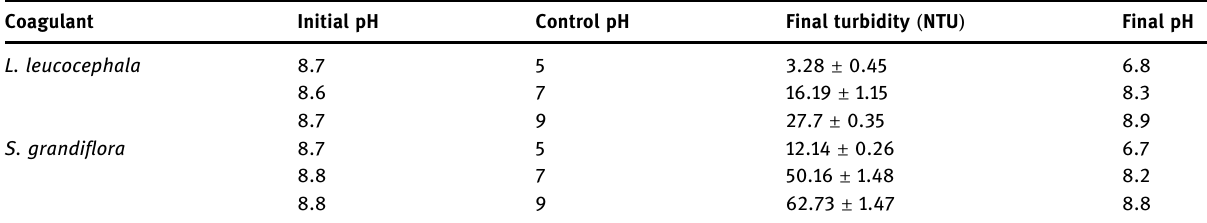
Table 2: E ff ect of pH on the removal of turbidity from turbid water Coagulant Initial pH Control pH Final turbidity ( NTU ) Final pH